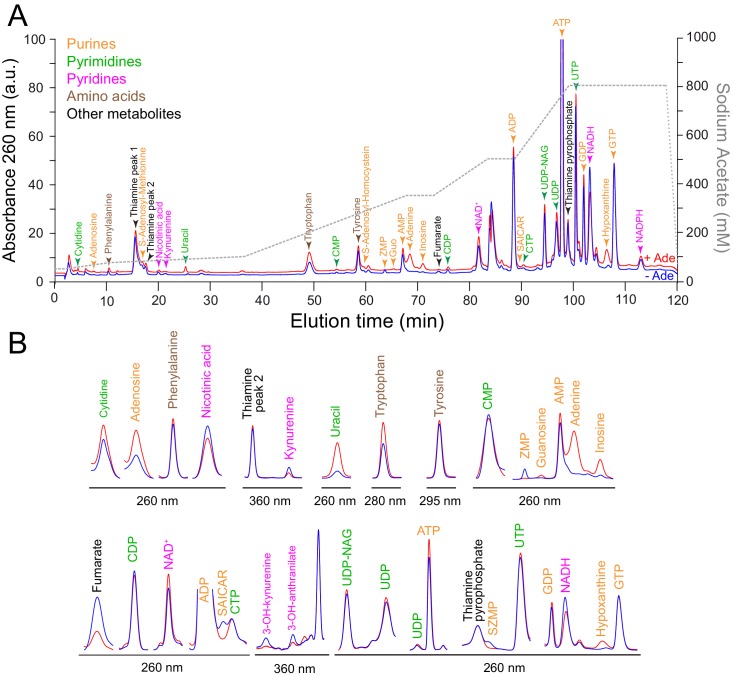
Separation of intracellular metabolites by high-performance ion chromatography.A prototrophic yeast strain (FY4) was grown in SDcasaWU medium ±Adenine. Metabolite extraction and separation by liquid chromatography were performed as described in the Materials and methods section. (A) Typical entire chromatograms obtained at 260 nm in the presence (red line) or the absence (blue line) of external adenine (Ade). Similar patterns were found in all metabolic extractions presented in Figure 2. Identified peaks are indicated with a color code corresponding to metabolite families. (B) Zooms of absorbance signals obtained from chromatogram at indicated wavelengths. ADP: adenosine 5’-diphosphate, AMP: adenosine 5’-monophosphate, ATP: adenosine 5’-triphosphate, CDP: cytidine 5’-diphosphate, CMP: cytidine 5’-monophosphate, CTP: cytidine 5’-triphosphate, GDP: guanosine 5’-diphosphate, GTP: guanosine 5’-triphosphate, NAD+: nicotinamide adenine dinucleotide, NADH: nicotinamide adenine dinucleotide reduced form, NADPH: phosphorylated form of NADH, SAICAR: succinyl-aminoimidazole carboxamide ribonucleoside, UDP: uridine 5’-diphosphate, UDP-NAG: uridine 5’-diphosphate-N-acetyl glucosamine, UTP: uridine 5’-triphosphate, ZMP: 5-amino-4-imidazole carboxamide ribonucleotide 5′-phosphate and SZMP: succinyl-ZMP.